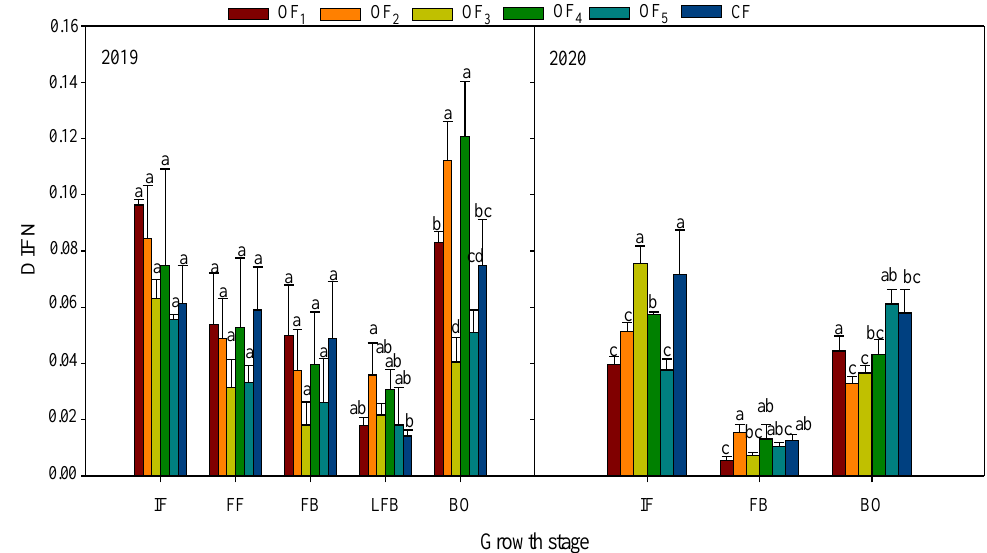
Figure 4. Effect of organic liquid fertilizer combined with different ratios of chemical fertilizers on cotton canopy openness. IF, initial flowering stage; FF, full−flowering stage; FB, full−boll stage; LFB, late full−boll stage; BO, boll−opening stage. Different letters above the columns indicate statistical significance at the p = 0.05 level within the same growth stage in each year.